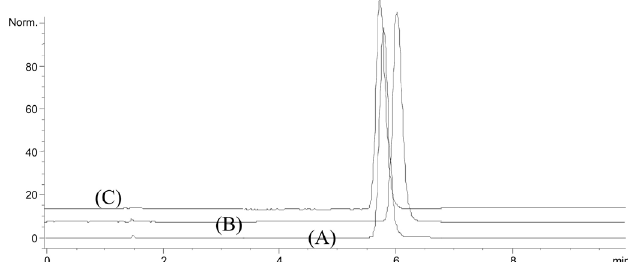
FIGURE 3 - Chromatograms of lamotrigine reference